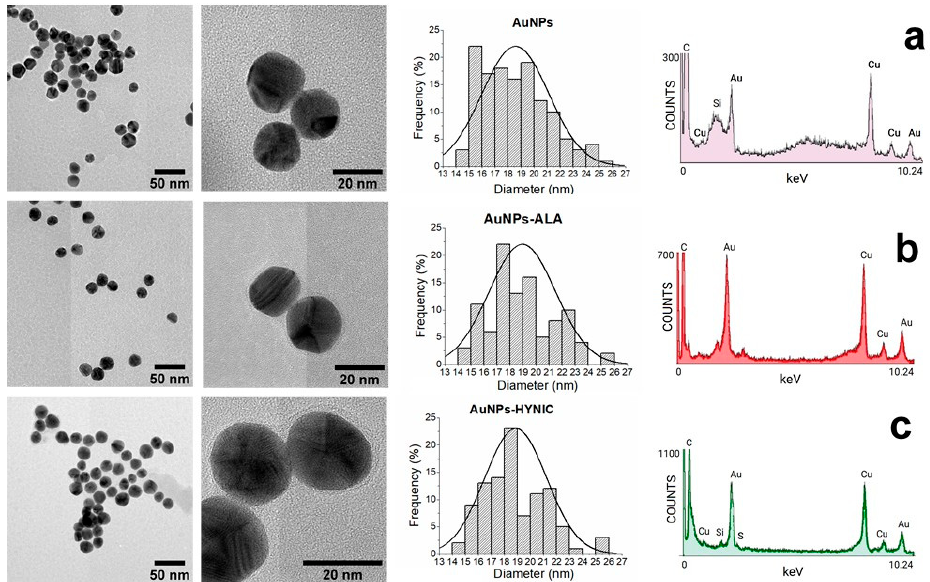
Figure 3. Representative transmission electron microscopy images, size histogram distribution, and HRTEM analysis for ( a ) AuNPs, ( b ) AuNPs-ALA, and ( c ) AuNPs-MAN. Results correspond to the 48 h incubation group.